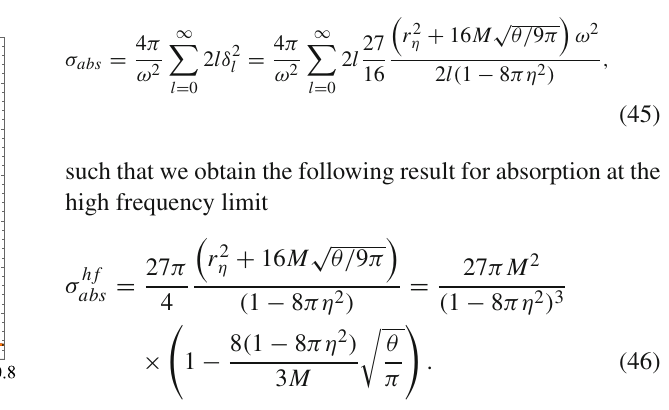
Fig. 2 Here we see the behavior of the absorption cross section for l = 0 when varying M from 1 to the minimum mass value, corresponding to the values of the parameters (cid:11) and